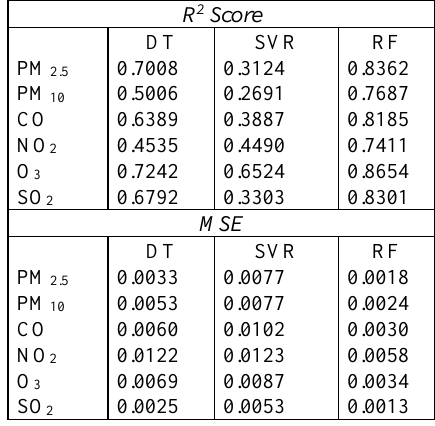
Table 4. Results Obtained for Wanshouxigong Weather Station Data